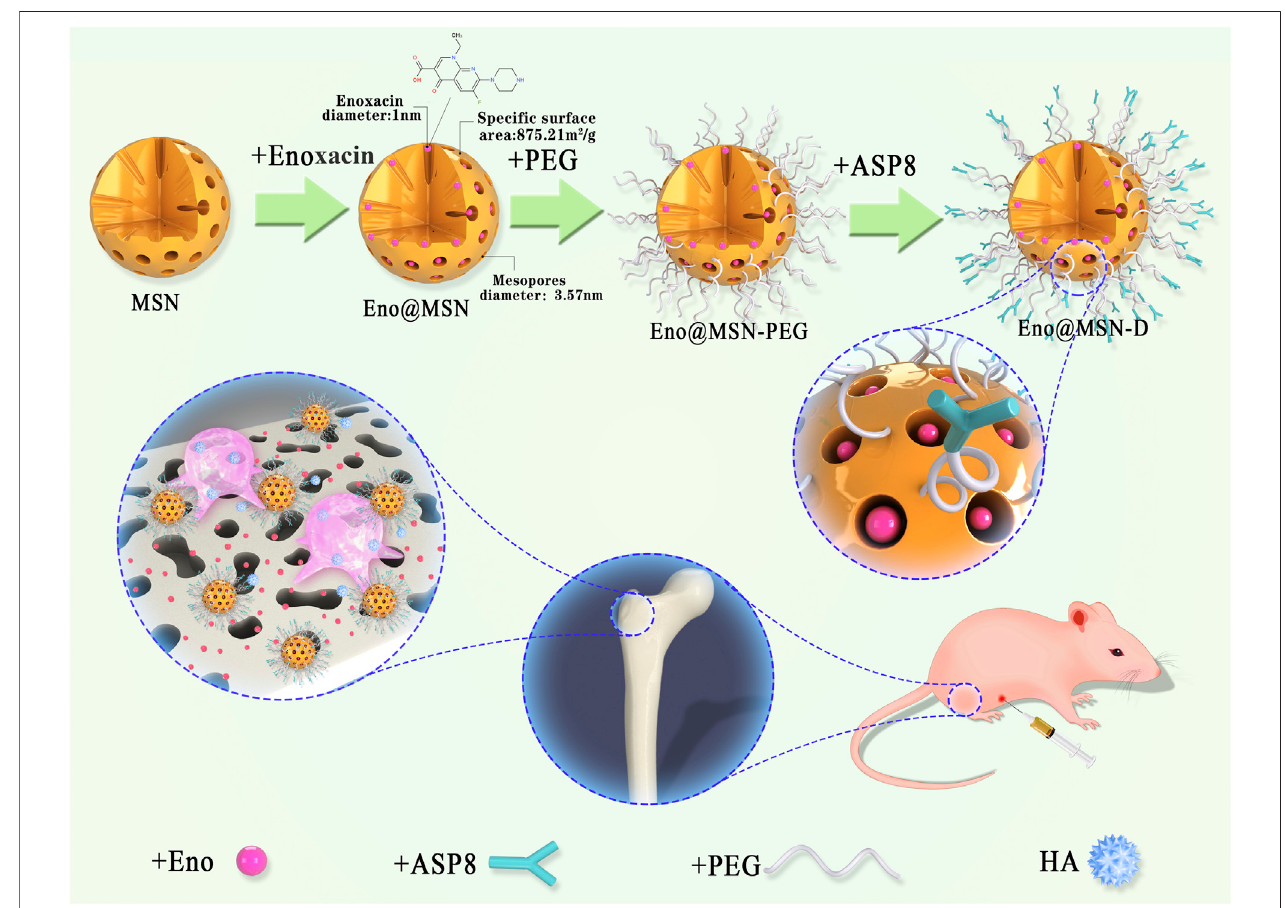
FIGURE 1 | Schematic diagram of the process fl ow for synthesising Eno@MSN-D nano slow-release particles based on mesoporous silica nanoparticles (MSN) and schematic diagram of the action mechanism of Eno@MSN-D nanoparticles.